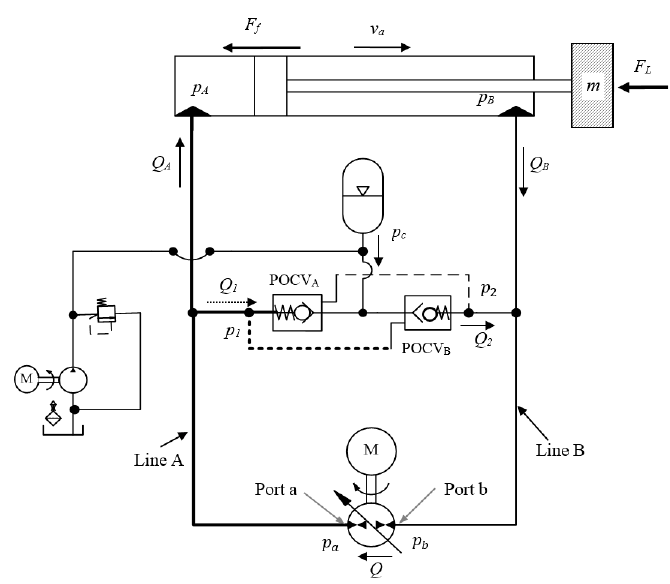
Figure 1. Circuit utilizing pilot-operated check valves.